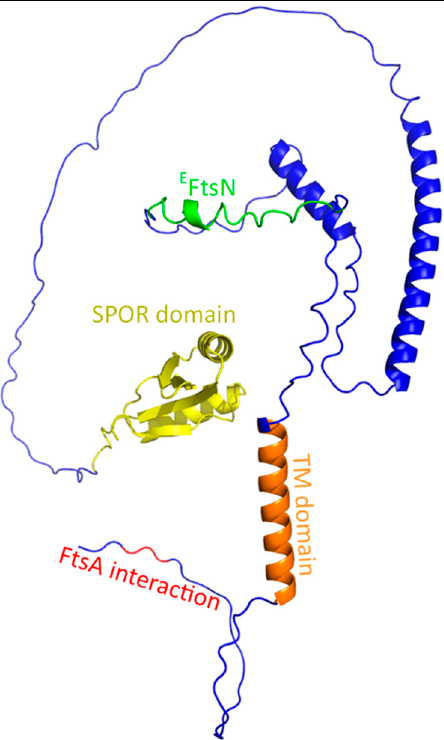
Figure 8. FtsN structure. FtsN is a long bitopic protein, with a small cytoplasmic domain that interacts with FtsA (red), a transmembrane domain (orange), and a large periplasmic domain. The periplasmic domain is mostly unstructured, ending in a SPOR domain that binds to denuded glycans. The region in between the membrane and the SPOR domain contains three α -helixes, including an essential domain of 18 residues (green: E FtsN domain) partly located on the first helix.